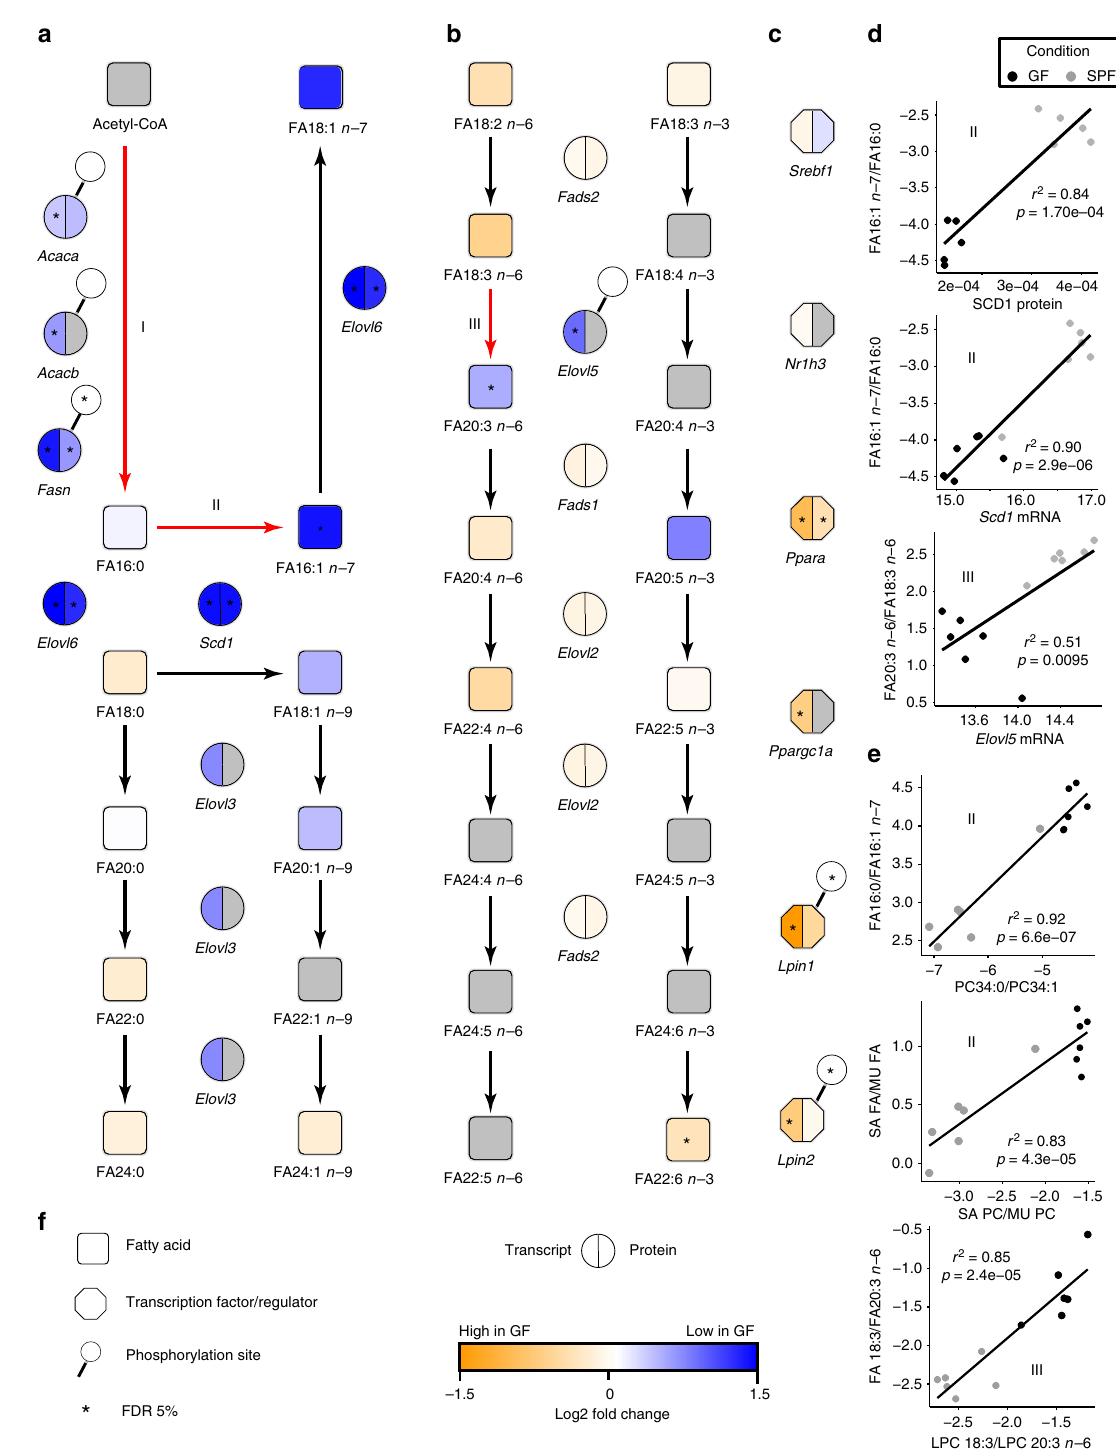
Fig. 3 Reconstruction of FA metabolic pathways from multi-omics data and FA-glycerophospholipid species correlations. a Cellular de novo synthesis of palmitate, elongation to saturated and desaturation to monounsaturated FA. b Metabolism of n -3 and n -6 PUFA. (I – III) indicate the key processes altered in GF compared to SPF mice. c Transcription factors and regulators controlling a and b . d Correlation of product to precursor ratios with the appropriate gene or protein expression for reactions (II) and (III). e Correlation of FA species ratios with corresponding PC or LPC ratios for reactions (II) and (III). f Legend for the fi gure highlighting the strength and direction of the association for all molecular entities shown. FA: fatty acid, LPC: Lyso-PC, MUFA: monounsaturated fatty acids, PC: phosphatidylcholine, PUFA: polyunsaturated fatty acids, SAFA: saturated fatty acids, for other abbreviations, see Table